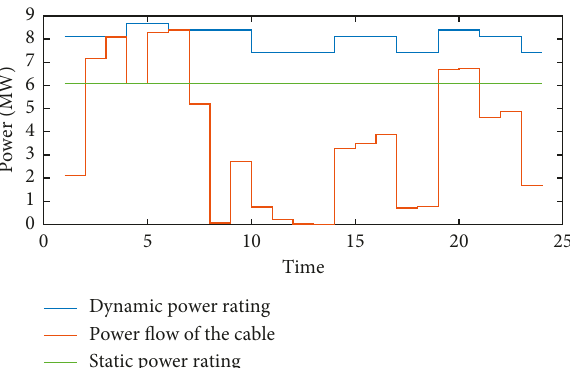
Figure 18: Dynamic power rating of the conductor, static power rating, and the power flow of the conductor when the system is operated at case study.